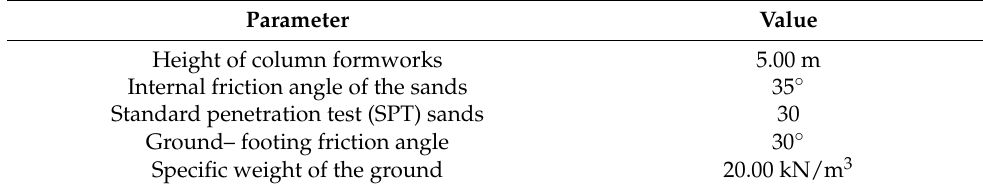
Table 1. Basic parameters of geometry and foundation